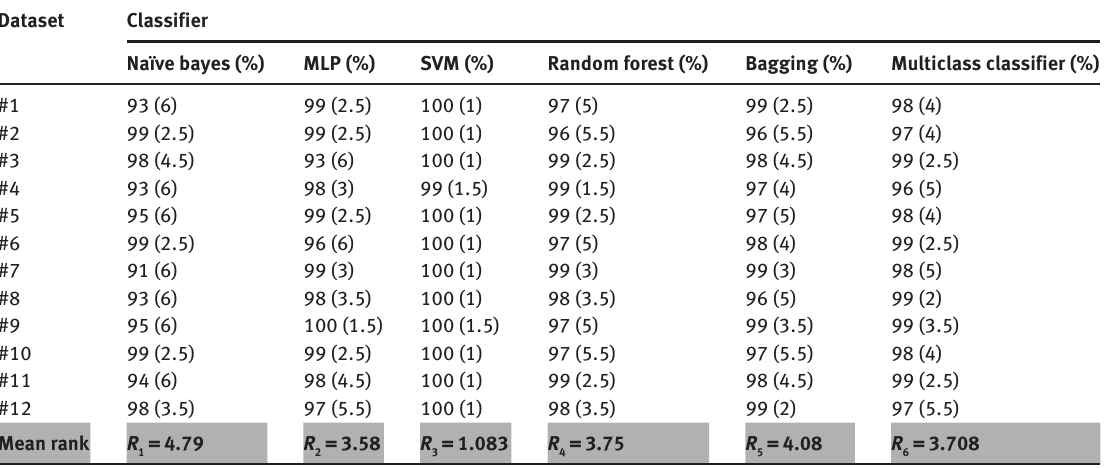
The mean ranks scored by individual classifiers are shaded in gray and styled in